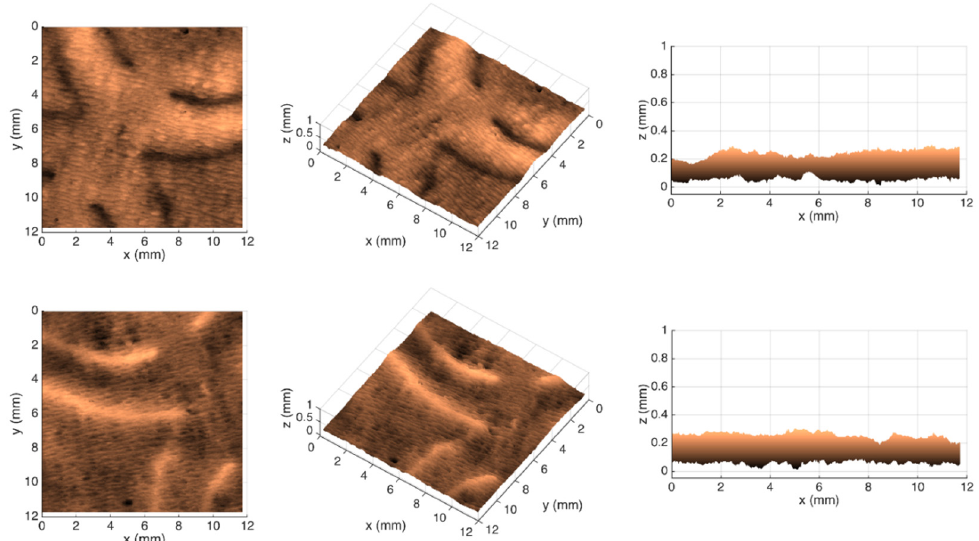
Figure 8. Different views of the 3D maps created for the front and back sides of the tissue-paper sample Bd rl .